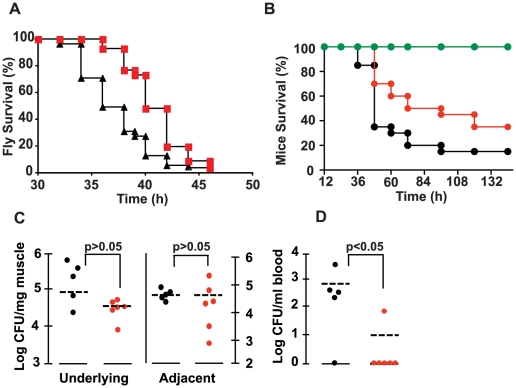
2-AA reduces P. aeruginosa virulence.(A) Survival kinetics of flies injected with a PA14 bacterial suspension with (∼1.6 ng/fly) and without 2-AA. Data were averaged from two experiments with n(PA14) = 55 and n(PA14+2-AA) = 56. Significance of difference of survival rate was calculated using the log-rank test of the Kaplan Meier survival estimate (p = 0.0056). (B) Survival rates of mice infected with PA14 versus PA14 + 67 µg of 2-AA/mouse. The data correspond to the averages of two independent experiments, with n(PA14) = 20 and n(PA14+2-AA) = 20. Significance of difference of survival rates was calculated using the Kaplan-Meier method (p = 0.03), with a hazard ratio of 1.8932 (95% CI, 1.0664 to 6.0718). (C and D) Bacterial loads in the local and adjacent muscle and in blood were determined for control and 2-AA treated mice, at 20 h post-burn and infection. The statistical significance of the CFU/mg muscle tissue differences between the control and experimental mice were determined using the Mann-Whitney test for independent samples, with p = 0.43 for the difference in the underlying and adjacent muscle in response to 2-AA, and p = 0.045 for the difference in the blood in response to 2-AA. CFU data are presented as log 10. Black PA14, red PA14+2-AA, green 2-AA only.